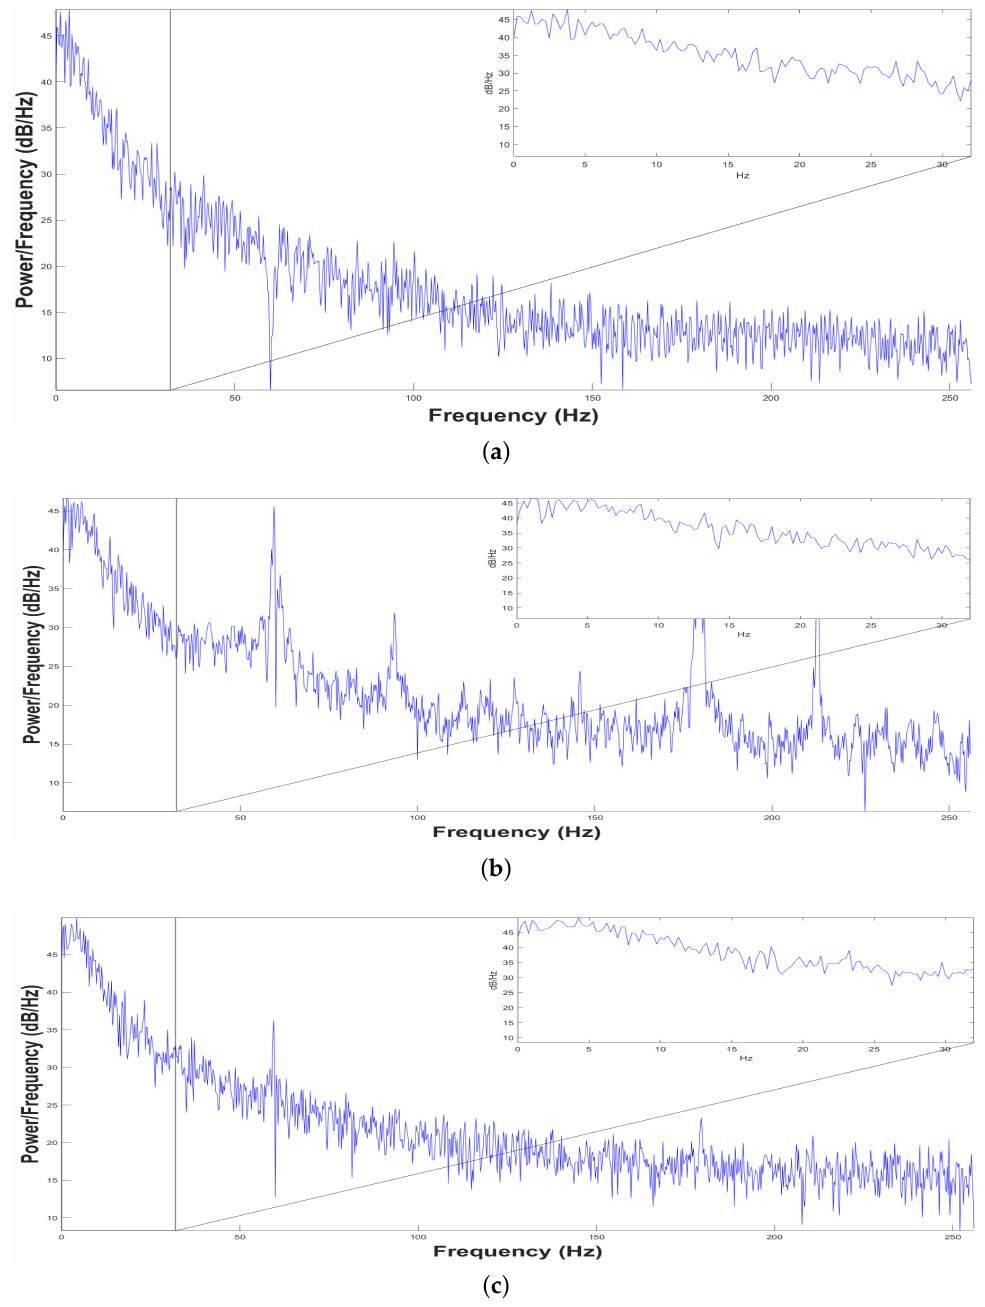
Figure 4. Power Spectrum Density from 0.5 to 256 Hz. ( a ) First sample, ( b ) Second Sample and ( c ) Third